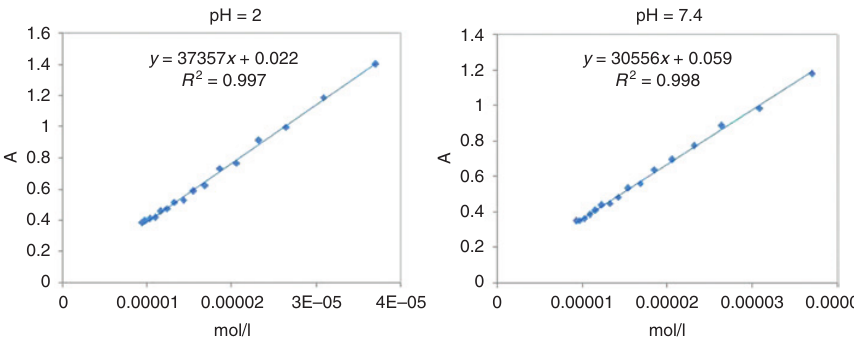
Figure 5: The absorbance versus different Hq content in pH 2.0 and pH 7.4 solutions.